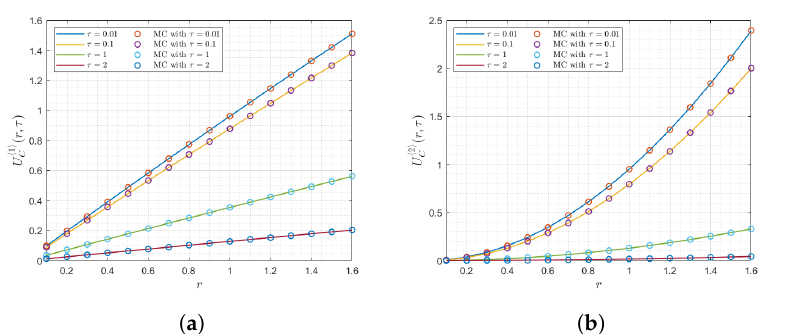
(cid:104) n (cid:105) ( r , τ ) for the initial rates r = 0.1,0.2,0.3, . . . ,1.6 and C (cid:104) 1 (cid:105) ( r , τ ) . ( b ) Conditional expectation U (cid:104) 2 (cid:105) C